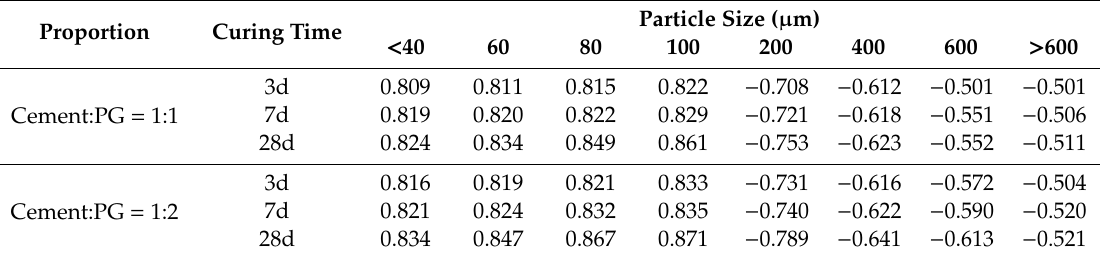
Table 9. Correlation degree between PG grades and unconfined compressive strength of cement–PG cementitious